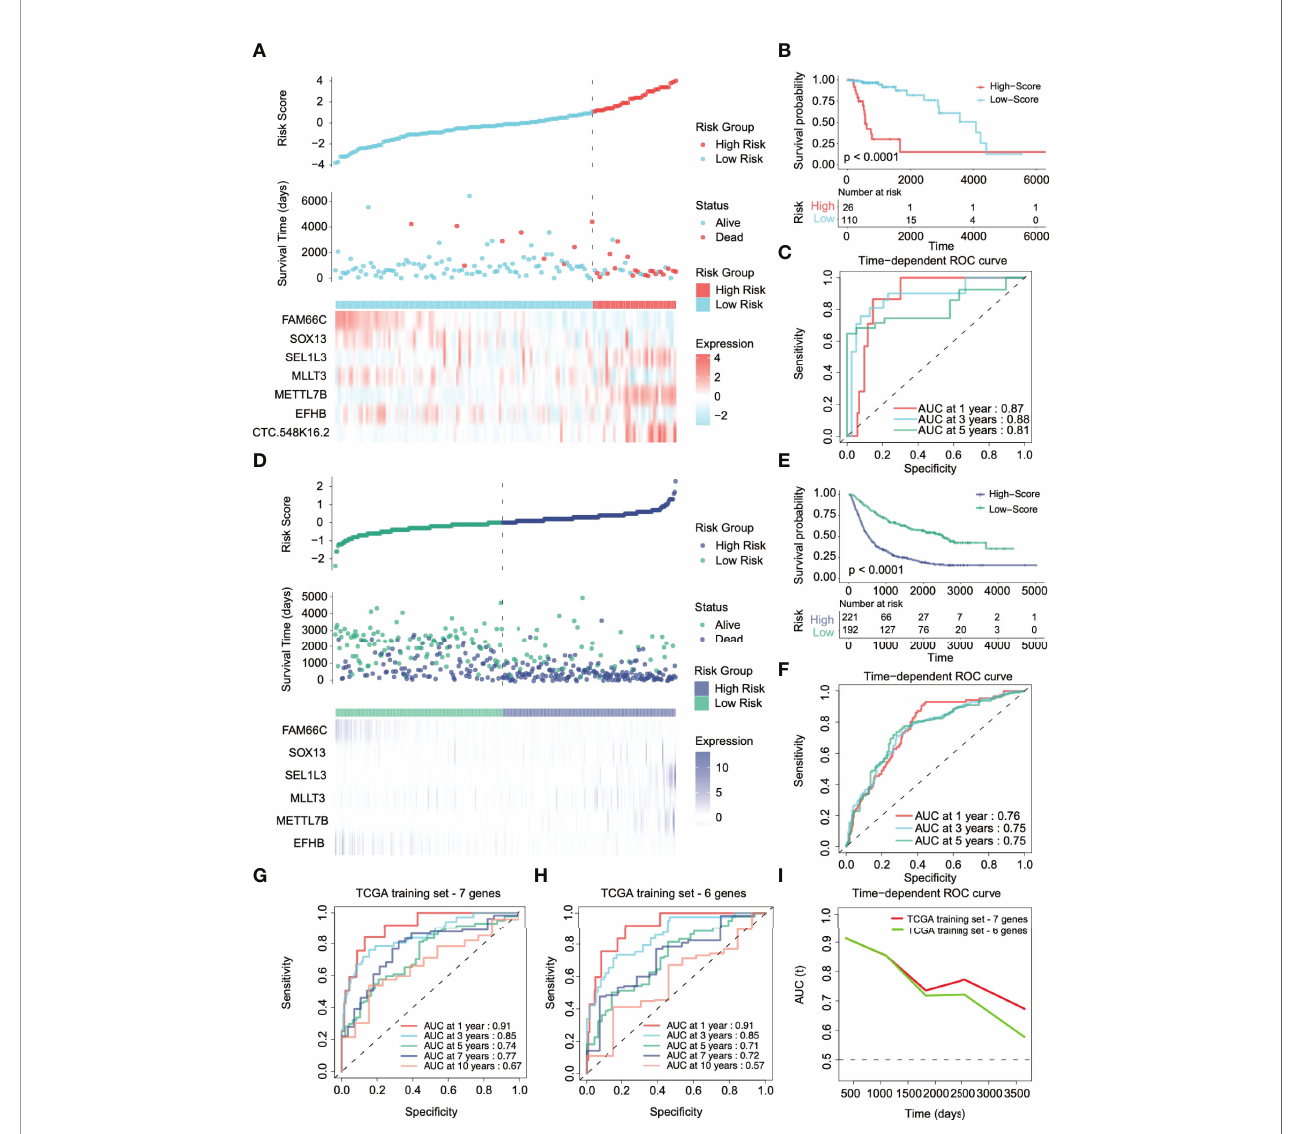
FIGURE 3 | Validation of the prognostic performance of the risk strati fi cation gene signature in TCGA and CGGA cohorts. (A, D) Distribution of risk score, survival time, and gene expression panel in TCGA and CGGA validation cohorts. (B, E) Kaplan – Meier curves of OS based on the risk score in the TCGA and CGGA cohorts. (C, F) ROC curve of the risk gene signature at 1, 3, and 5 years in the TCGA and CGGA cohorts. (G, H) Time-dependent ROC curve of the risk gene signature at 1, 3, 5, 7, and 10 years in the TCGA cohort with and without CTC-548K16.2. (I) The area under the ROC curve (AUC) of prognosis prediction using different risk strati fi cation models in the TCGA